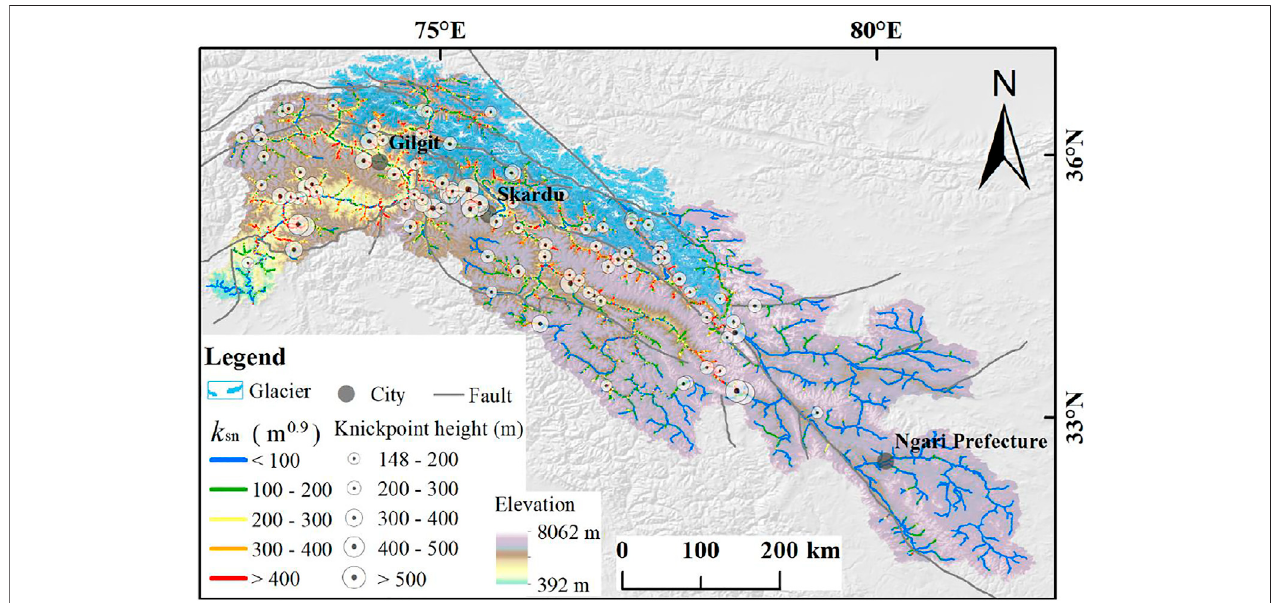
FIGURE 7 | Distribution of knickpoints and normalized channel steepness ( k sn ) in the river network of the upper Indus River.